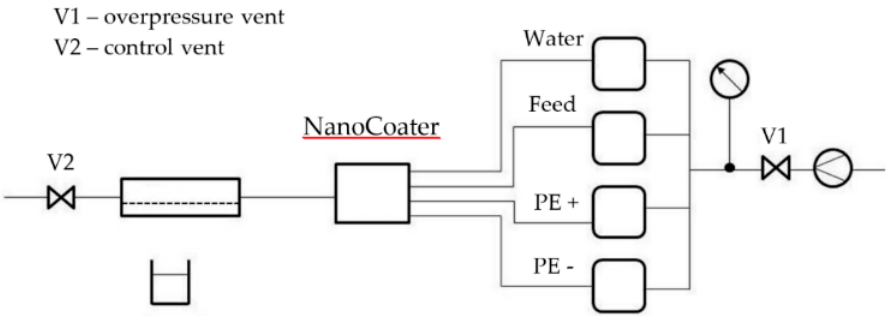
Figure 2. “NanoCoater”-system for coating the capillary membranes with